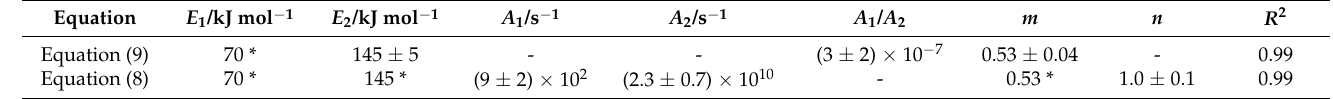
Table 1. Estimated kinetic parameters of the Kamal model for polymerization of dicyanate ester.